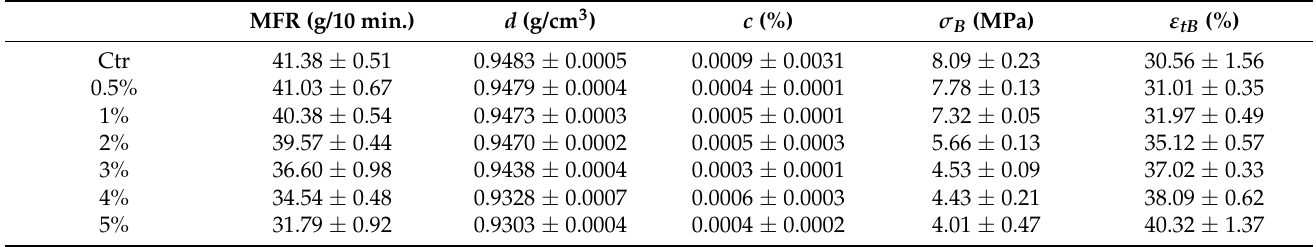
Table 1. Results of physicomechanical tests of samples with biocide (from 0.5% to 5%) and control samples without biocide (Ctr); arithmetic means ± standard deviation.